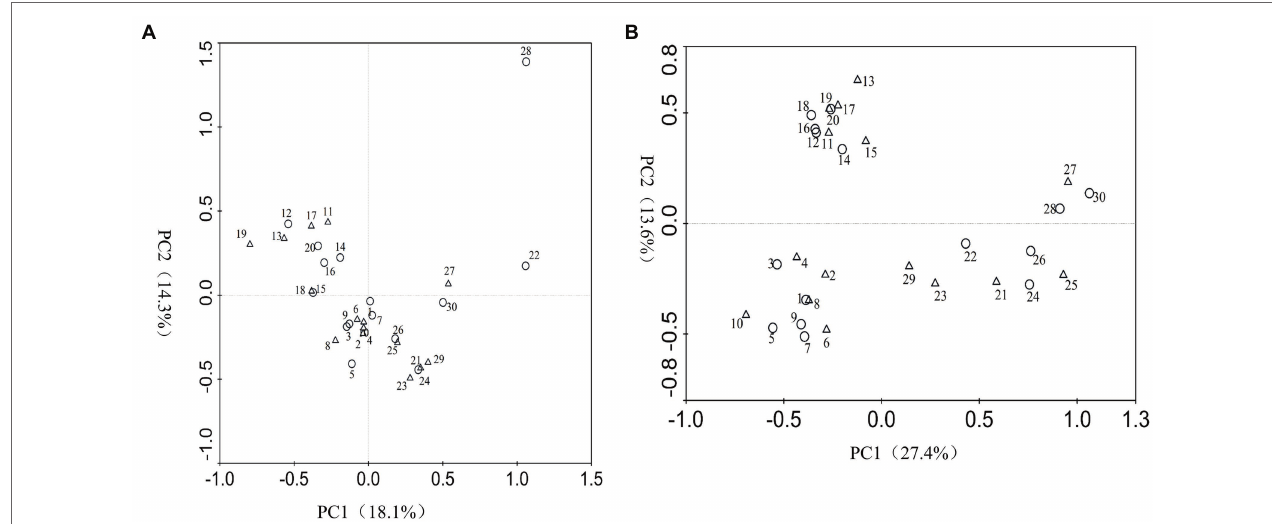
FIGURE 5 | Principal components analysis (PCA) of fungi (A) and bacteria (B) species generated from DGGE band patterns. Circle represents pine seedlings non- inoculated with PWN, and triangle represents pine seedlings inoculated with PWN. 1~10, 11~20, and 21~30 represent samples from P. tabulaeformis seedlings inoculation of A. vaginata , S. bovines, G. cylindrosporus , P. chrysanthemicola , and control treatments at 3, 6, and 9 months after PWN infection, respectively. PC1, principal component 1; PC2, principal component